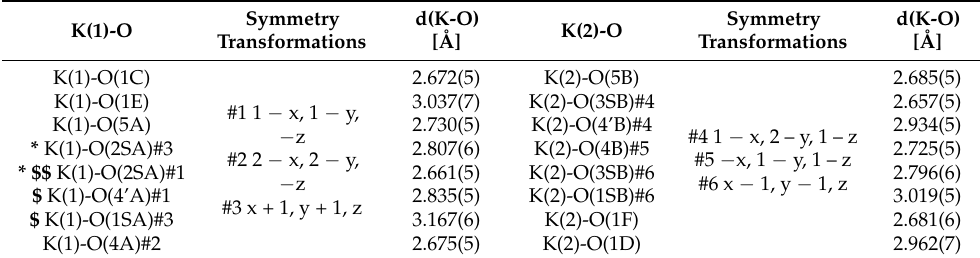
Table 6. The geometry of the cationic coordination spheres in 3 .